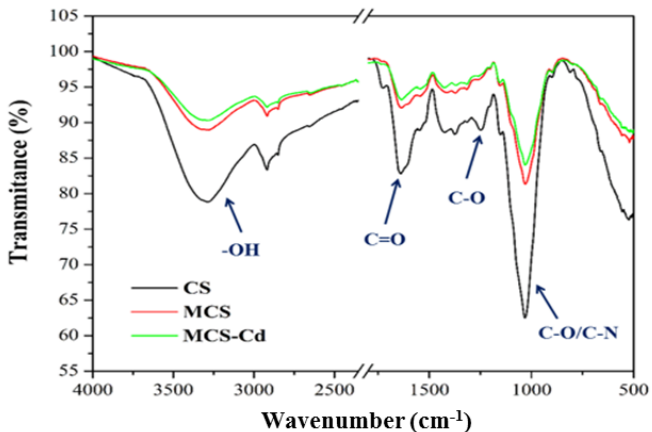
Figure 3. FTIR spectra of the CS and MCS before and after Cd 2+ adsorption.